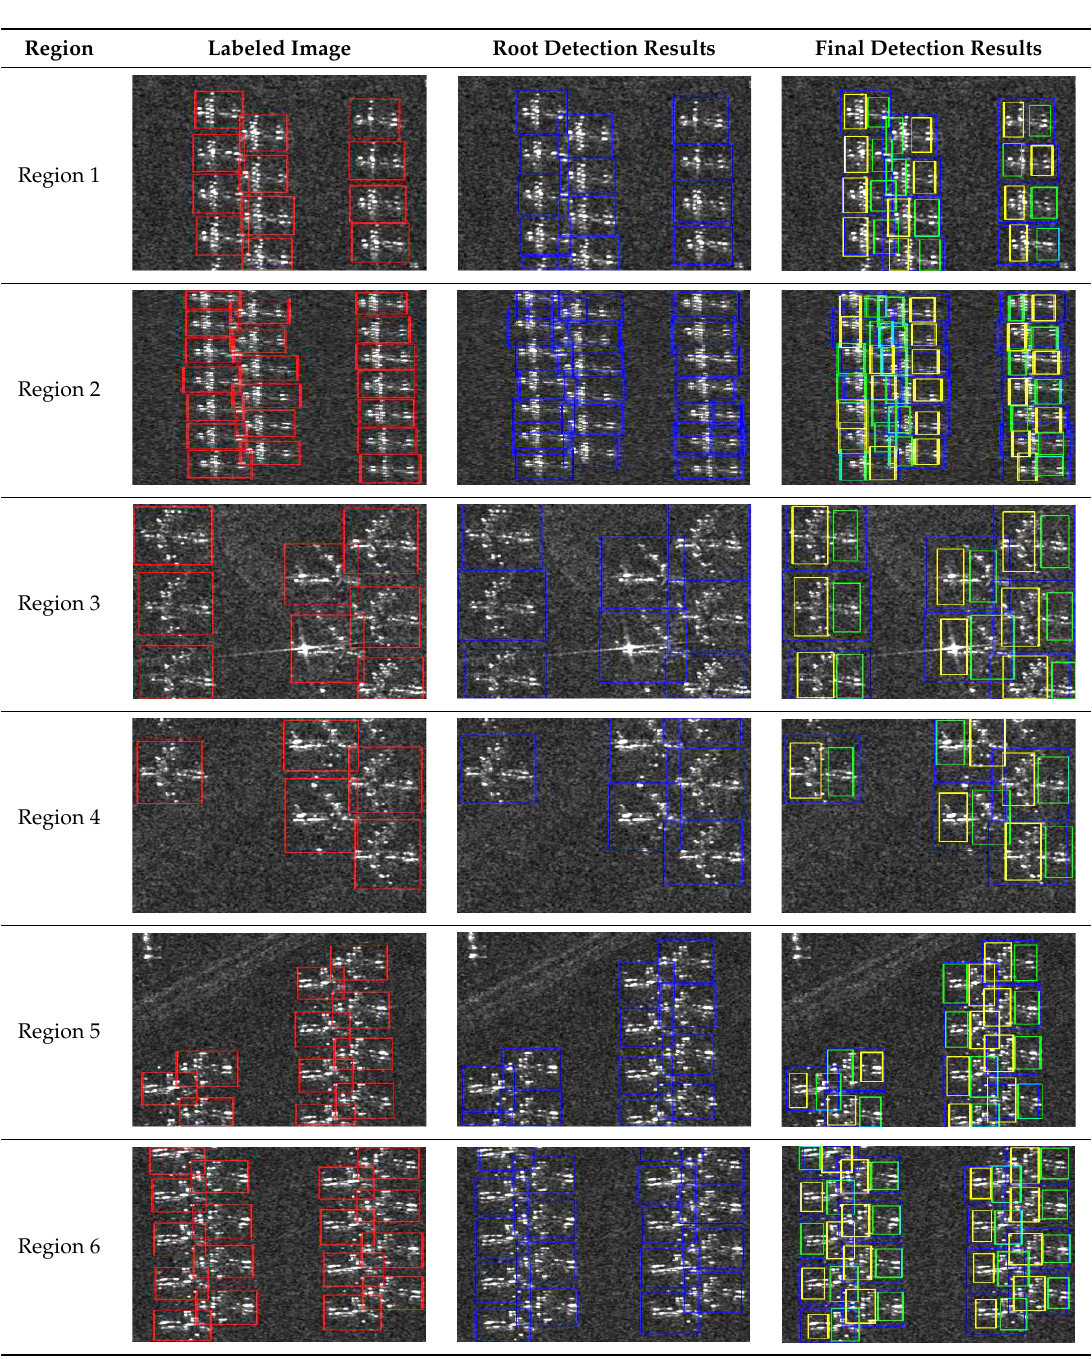
Table 2. Detection results of the proposed